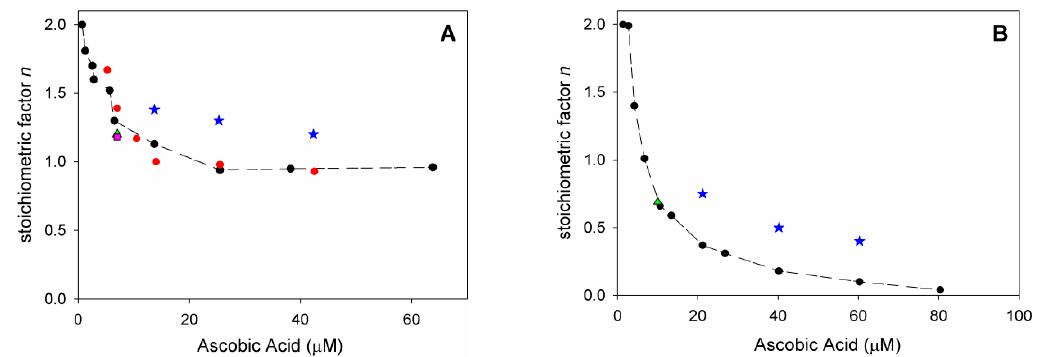
Figure 5. Variation of stoichiometric factor n : ( A ) during the autoxidation of Cumene (1.8 M) initiated by AIBN (0.05 M) in acetonitrile at 30 ◦ C (red), and upon addition of: 1% water (black), HNTs 0.25 mg/mL (green), 1% water and HNTs 0.25 mg/mL (pink) inhibited by variable amount of AH 2 (7.0 × 10 − 7 M to 6.4 × 10 − 5 M, red, black, green, and pink), or inhibited by HNT/AH 2 (blue); ( B ) during the autoxidation of THF (3.1 M) initiated by AAPH (25 mM) in phosphate buffer 0.1 M pH = 7.4 at 30 ◦ C (black) and upon addition of HNTs 0.25 mg/mL (green), inhibited by variable amount of antioxidant AH 2 (1.4 × 10 − 6 M to 8.1 × 10 − 5 M, black and green) or inhibited by HNT/AH 2 (blue).